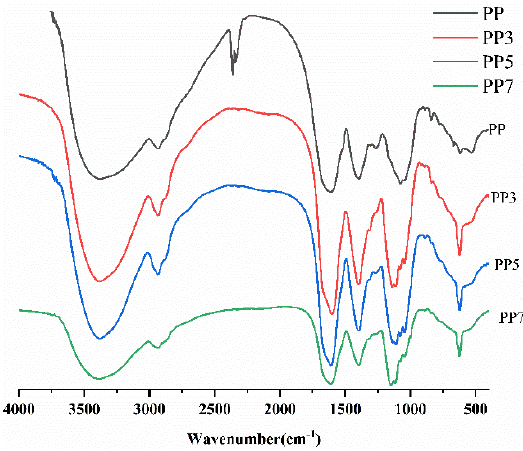
Figure 4. FT-IR spectra of PP, PP3, PP5, and PP7.